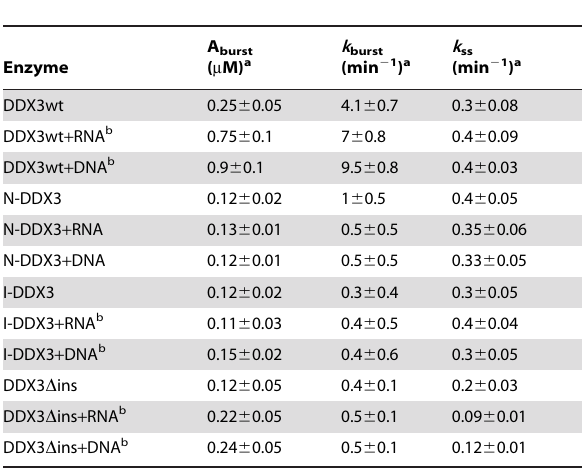
Table 2. Kinetics of the ATP-dependent reaction of DDX3wt and mutants with nucleic acids.